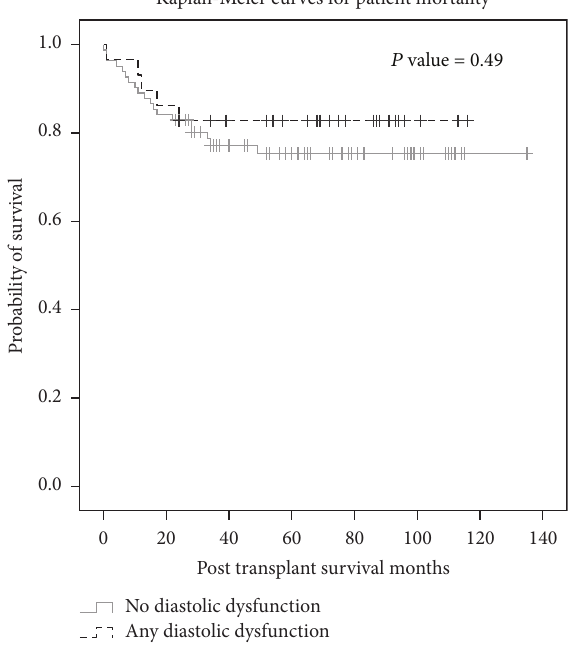
Figure 1: Kaplan-Meier curve shows that there is no significant difference in survival depending on diastolic dysfunction status.